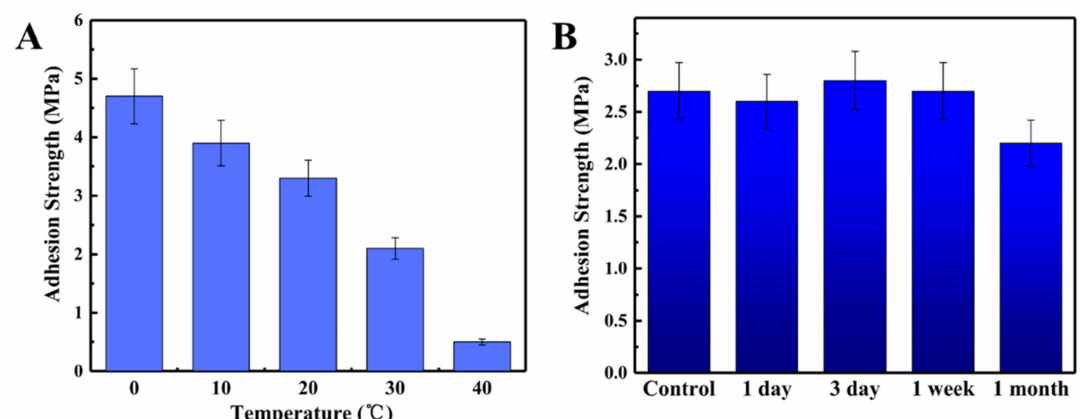
Figure 7. Wet adhesion strength of poly(DHHCA- co -LA)3 with 15 kPa preloading and at 95 ◦ C melting temperature under ( A ) different tensile test temperature and ( B ) different time steeping in water at room